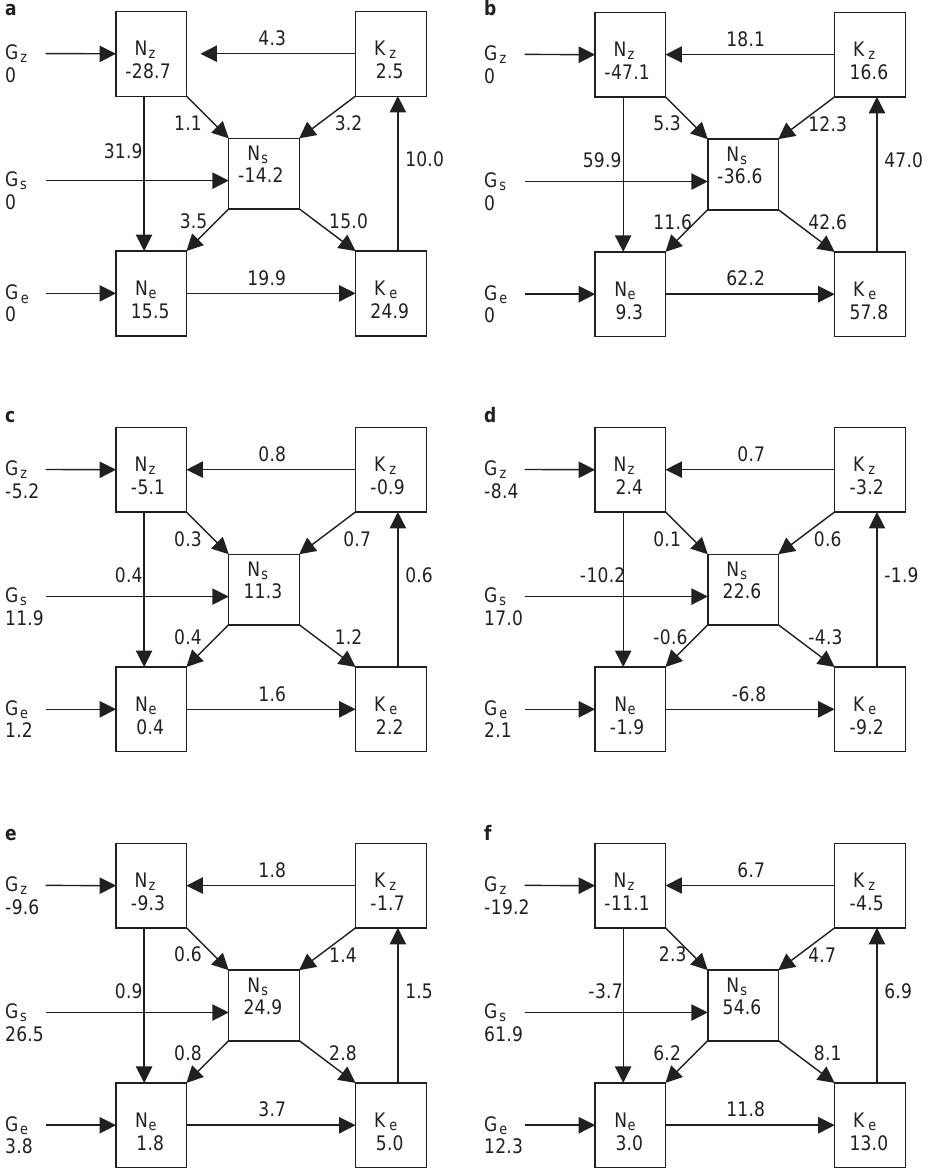
Fig. 6a–f. Energy box diagnos- tics showing rates of change and conversions between di(cid:128)erent forms of energy (units 10 5 J m (cid:255) 2 day (cid:255) 1 ) for three life cycle experiments: a, b DRY; c, d the anomaly G100ST60-DRY and c, f the anomaly G100- DRY. Values given are averages over days 5 to 7 ( a, c, e ) and days 8 to 10 ( b, d,